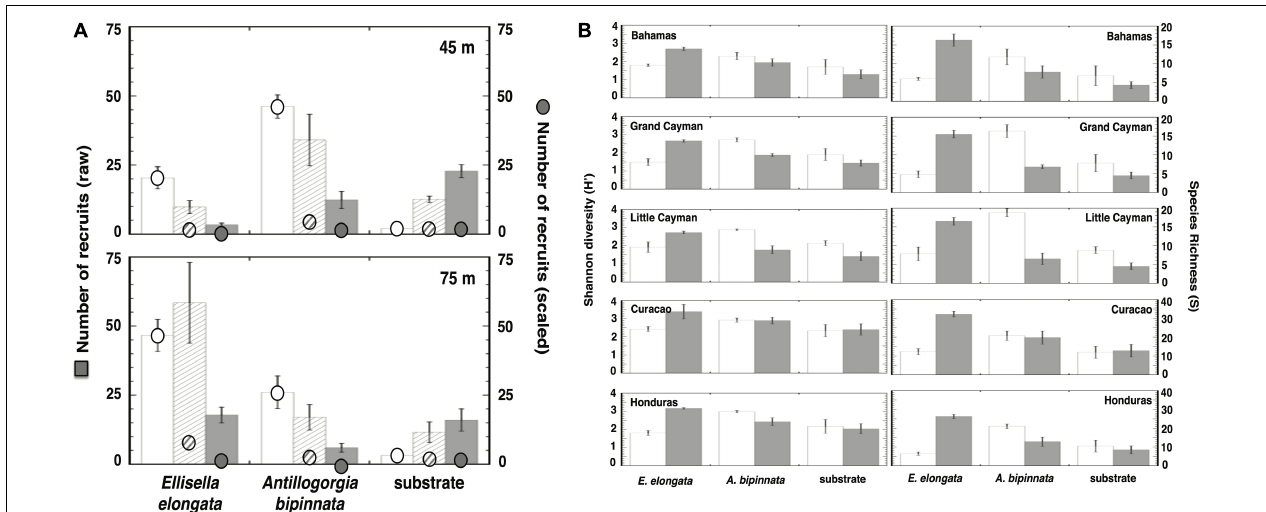
FIGURE 3 | Recruitment in the presence or absence of gorgonians from field surveys throughout the Caribbean. Histograms represent the mean ± SE. (A) Recruit numbers per m 2 (raw) and relative to area surrounding gorgonian (scaled: 400 cm 2 [white bars], 3,200 cm 2 [hatched bars], and 6,400 cm 2 [gray bars]; see Figure 4B ) at depths of 45 and 75 m. (B) Recruit diversity (H’) and richness (S) in the presence or absence of gorgonians from field surveys throughout the Caribbean (white bars = 45 m, gray bars = 75 m).